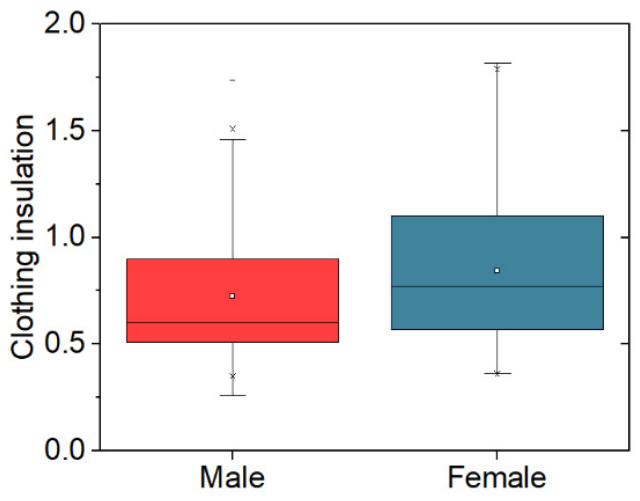
Figure 4. Distribution of clothing insulation values by gender. Red indicates males’ clothing insu- lation. Blue colour indicates females’ clothing insulation. Circle indicates the mean value.